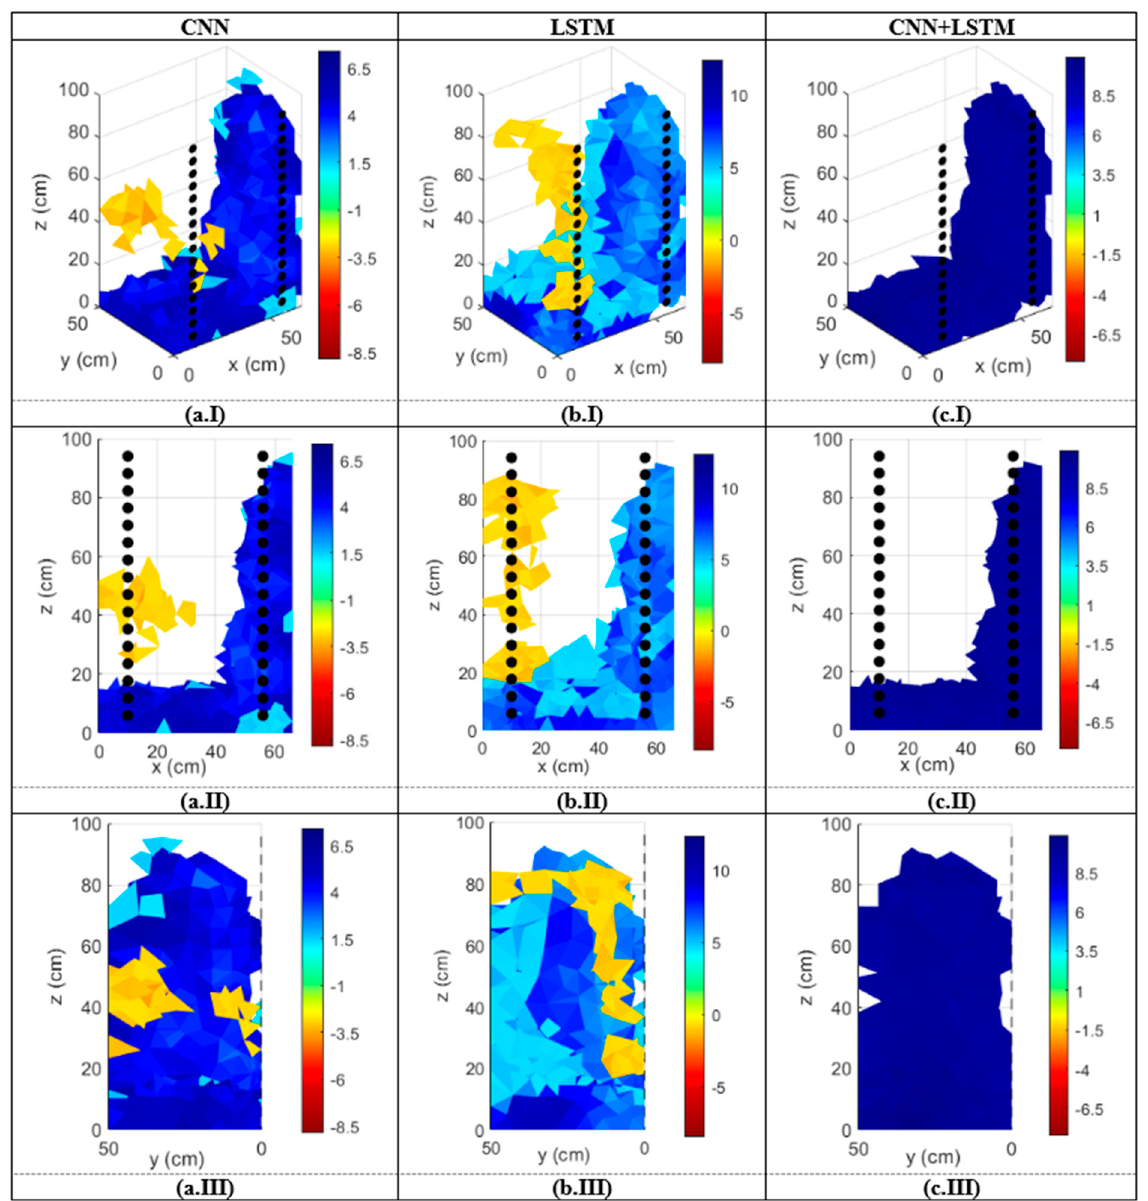
Figure 18. Reconstructions gained from real measurements: ( a.I – a.III ) refer to CNN, ( b.I – b.III ) refer to LSTM, and ( c.I – c.III ) refer to CNN+LSTM.